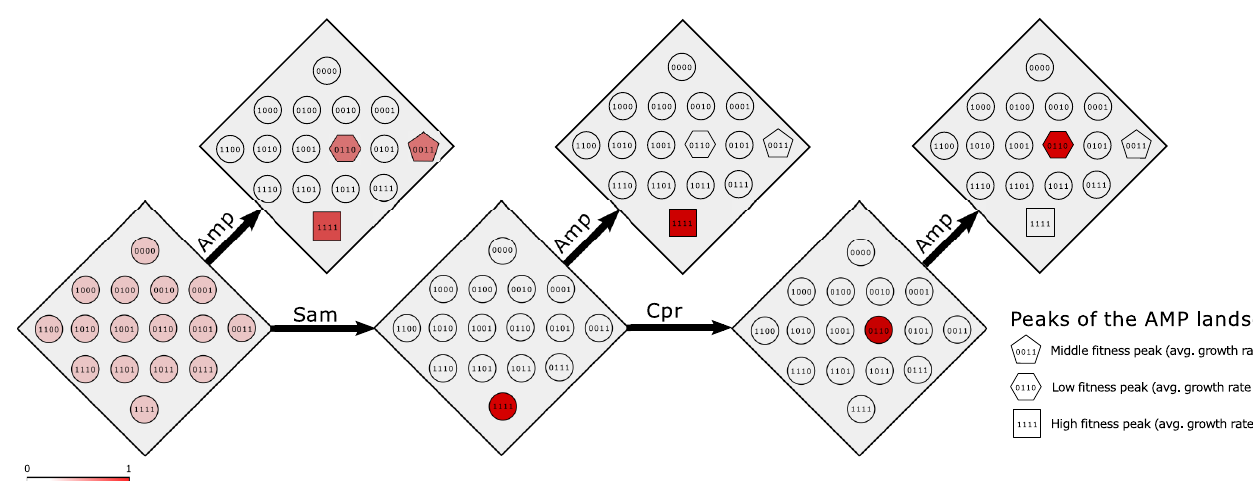
Fig 2. Steering evolution to prevent resistance. The probability distributions for accessibility of the peaks of the Amp landscape for different steering regimes. The initial distribution is μ = [1/2 N , ... ,1/2 N ]. When Amp is given first any of the three peaks of the landscape are accessible, with the most resistant genotype 1111 being most likely. If Sam is given first to steer the population to its sole peak 1111, then resistance to Amp will be guaranteed when it is applied. Alternatively, if Sam is given followed by Cpr, then the population evolves to the local optimum genotype 0110 of the Cpr landscape. If Amp is applied to this primed population the global optimum, 1111, is